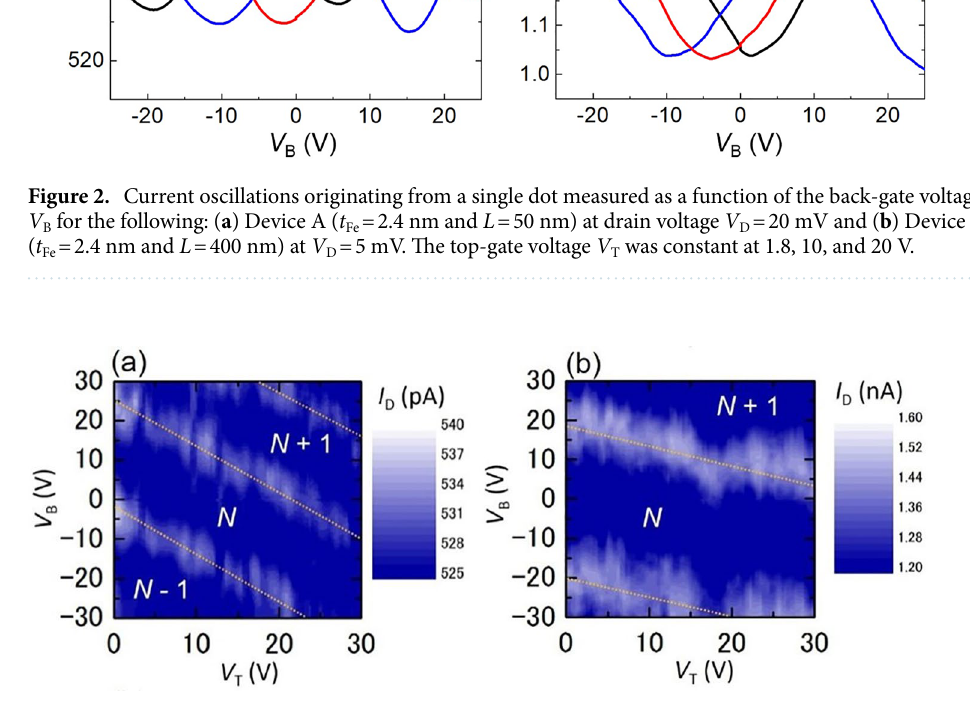
Figure 3. Typical two-dimensional contour-line maps of drain current I D as a function of V B and V T . ( a ) Device A at V D = 20 mV and ( b ) Device B at V D = 5 mV. N is the number of electrons in a single